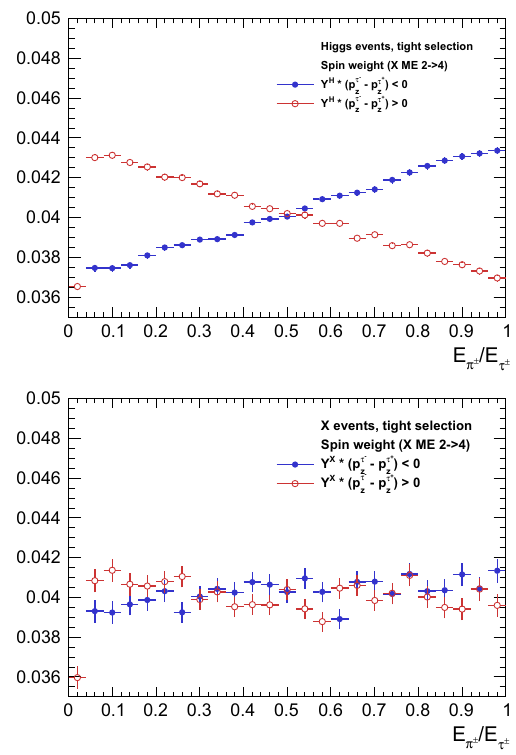
Fig. 6 Histograms of E π / E τ spectra, normalised to unity, for the H sample (top figure) and for the X sample (bottom figure). In all cases 2 → 4 matrix elements of X exchange are used to implement spin effects.Redopencirclepointsareforadditionalcuts Y X · ( p τ − 0 and the blue, full circle points for Y X · ( p τ − because far less X events survive tight selection, statistical errors on the bottom plot are